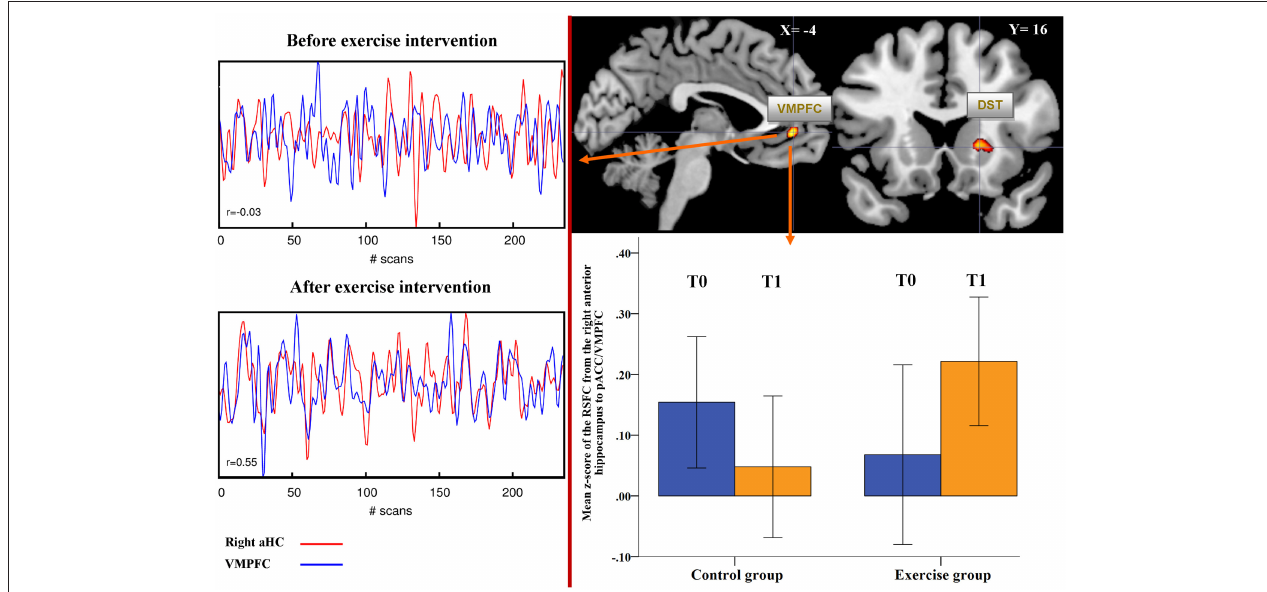
FIGURE 4 | Significant exercise-induced changes of the functional connectivity of the right aHC at the whole-brain level. On the right-hand side: significant Group (exercise vs. control group) × Time (before vs. after intervention) interaction ( post-hoc t-test ) for the functional connectivity (FC) of the right anterior hippocampus ( p < 0.001 uncorr, p < 0.05 cluster-level FWE corr.) at the whole-brain level. The box chart depicts significant changes in the FC between the right aHC and VMPFC/perigenual ACC (pACC). On the left-hand side: the correlations between the time series derived from the right aHC and the VMPFC/pACC are depicted